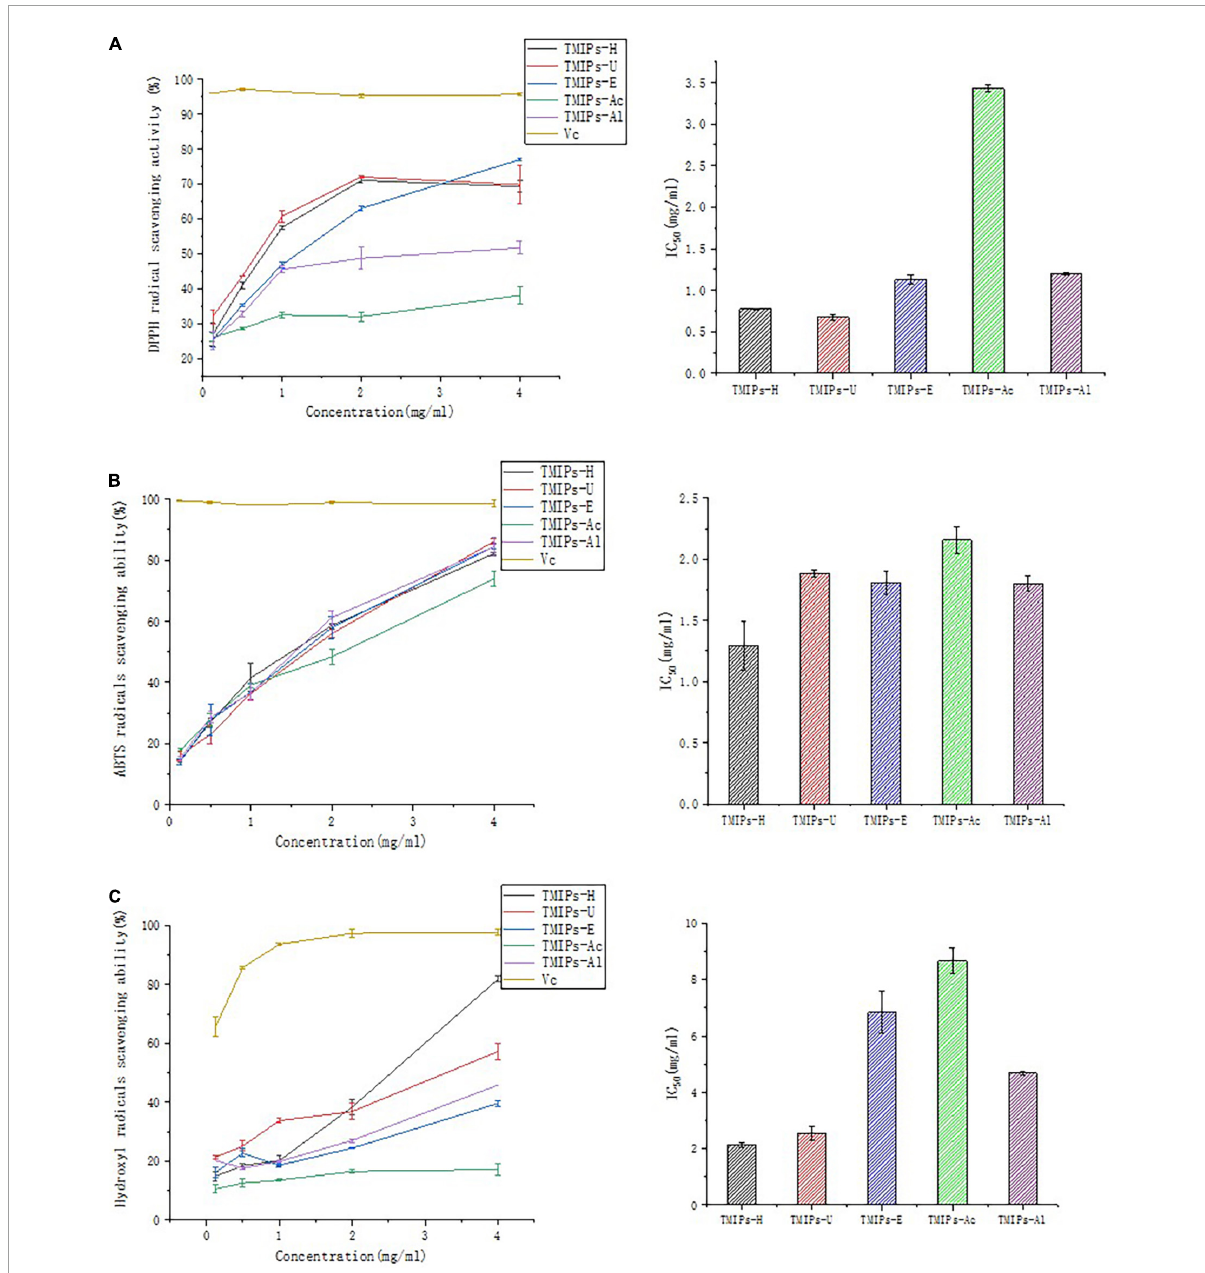
FIGURE6 Antioxidant activity of TMIPs. (A) DPPH free radical scavenging ability. (B) ABTS free radical scavenging ability. (C) Hydroxyl radicals scavenging